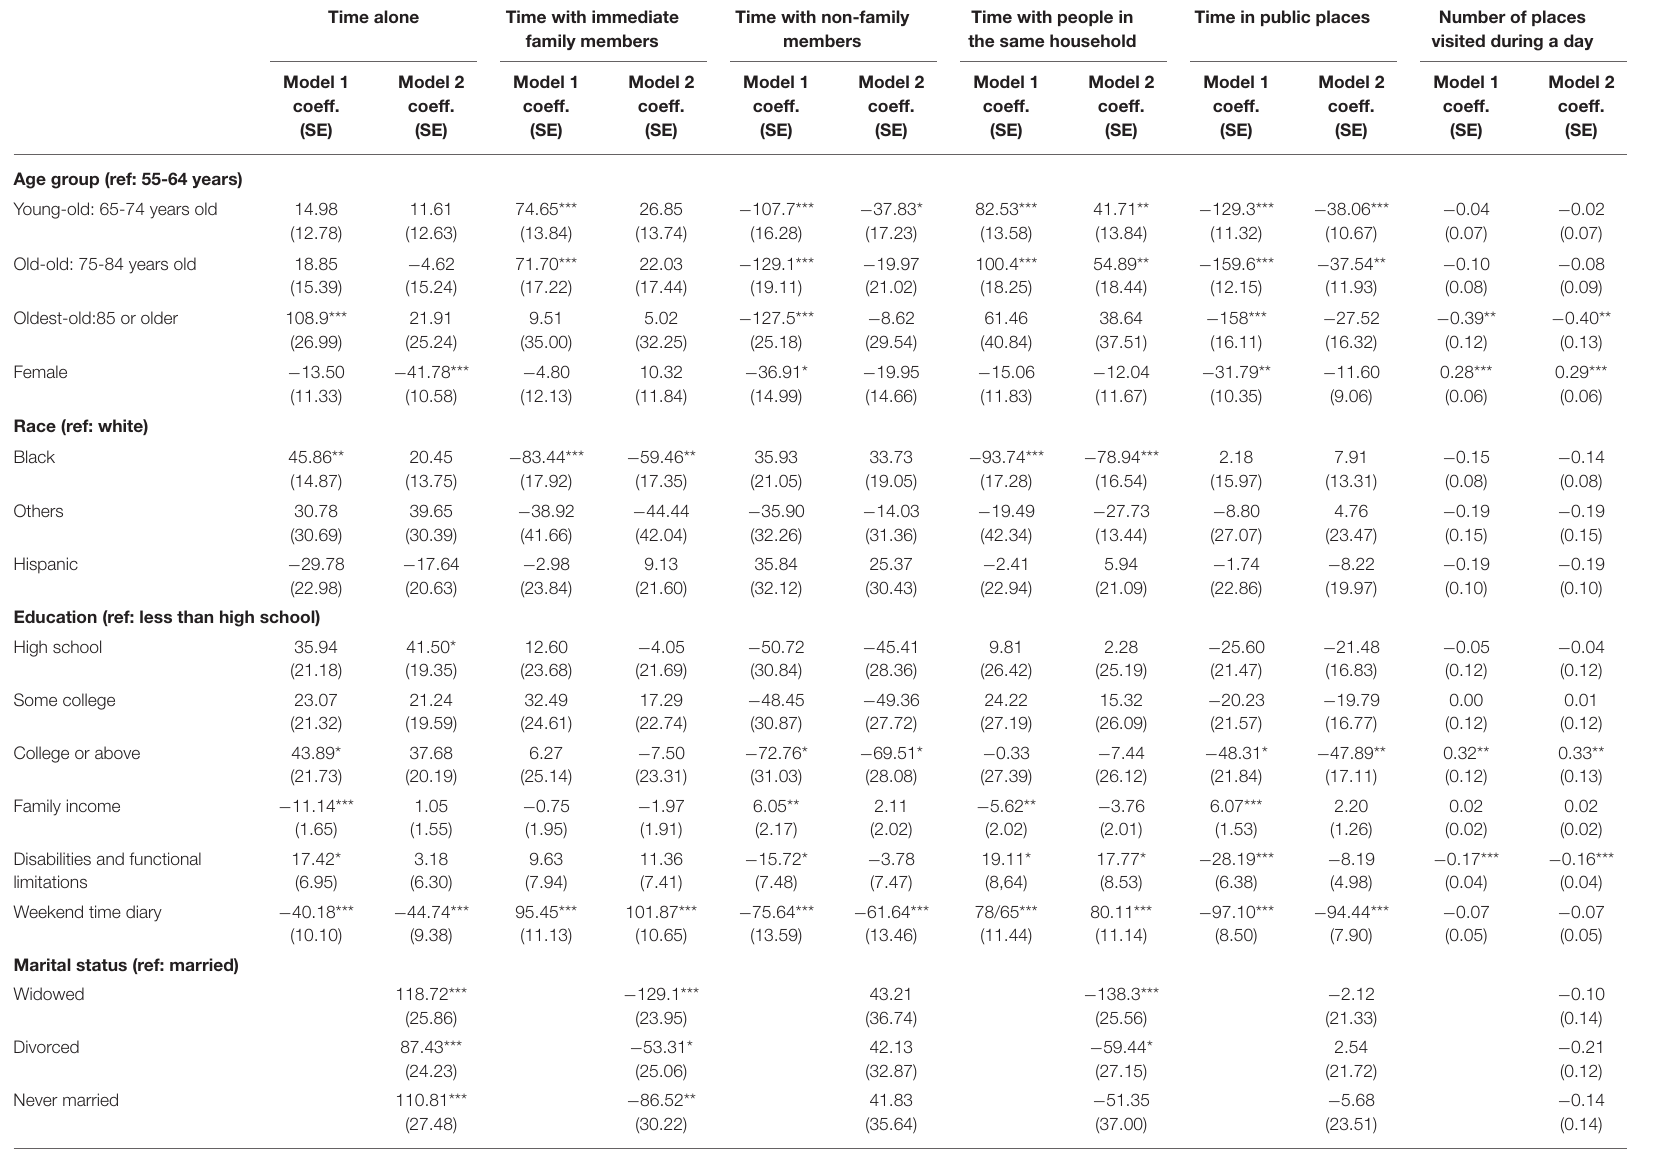
TABLE 3 | Results from hurdle model regressions linking age group to extent and degree of social contact in daily life ( N =